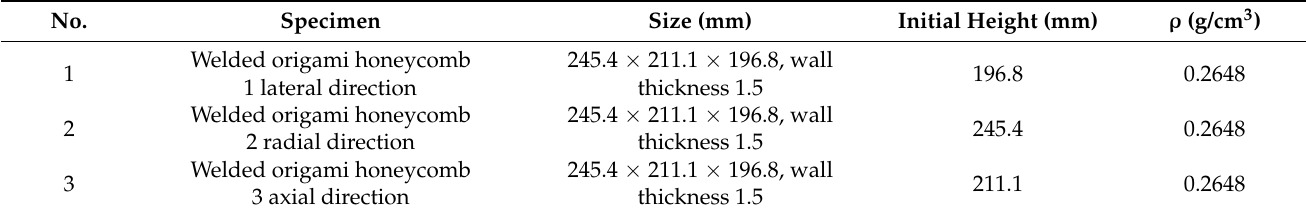
Figure 1. Preparation process of origami aluminum honeycomb material. Table 1. The origami aluminum honeycomb test samples.